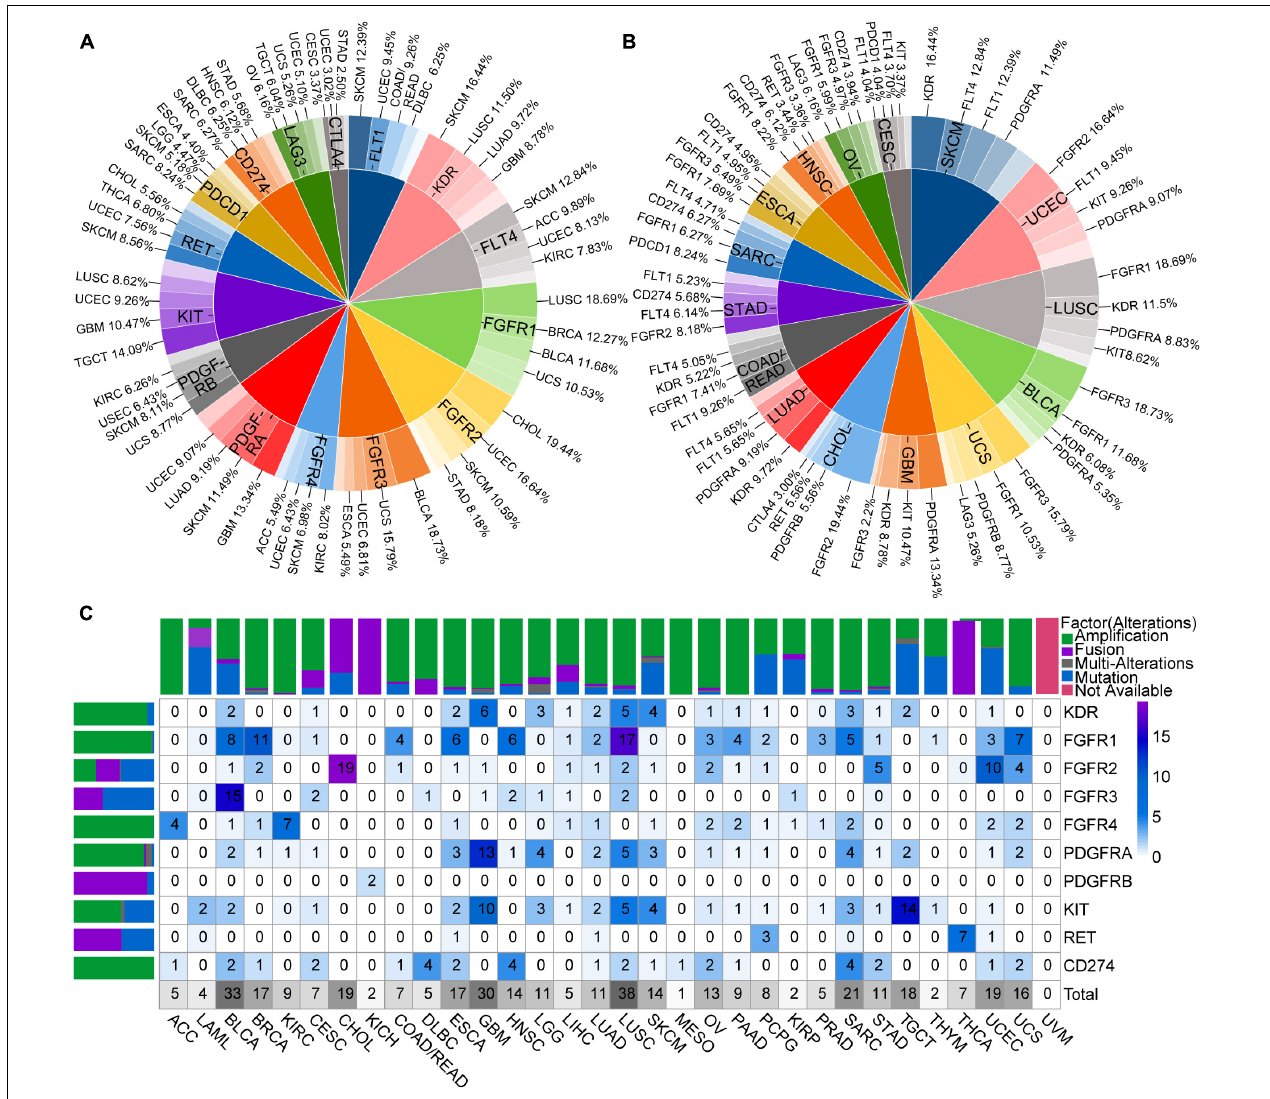
FIGURE 3 | Genomic alterations of ICB and lenvatinib target genes. (A) The most common types of cancers with particularly ICB and lenvatinib target genes alterations. (B) The most common types of target alterations in each cancer type. (C) Driver alterations types and proportions of ICB and lenvatinib target genes in different cancer types. The color of the block represents the proportion of alterations, and the number represents the percentage of alterations. Above is a column chart of alteration types in different cancer types, and on the left is a column chart of alteration types in different targets. ACC, adrenocortical carcinoma; DBLC, diffuse large B-cell lymphoma; LGG, low grade glioma; LAML, acute myeloid leukemia; MESO, mesothelioma; TGCT, testicular germ cell tumors; UCS, uterine carcinosarcoma; UVM, uveal